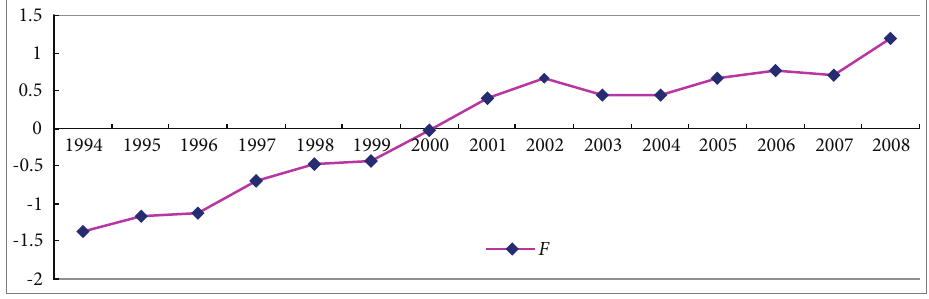
Fig. 2. Composite Component Score (F) of Qingdao Science Park (1994-2008)